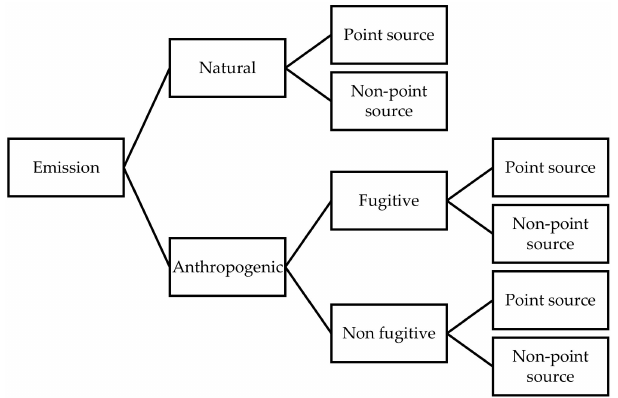
Figure 4. Categorization system of methane emissions according to the definitions